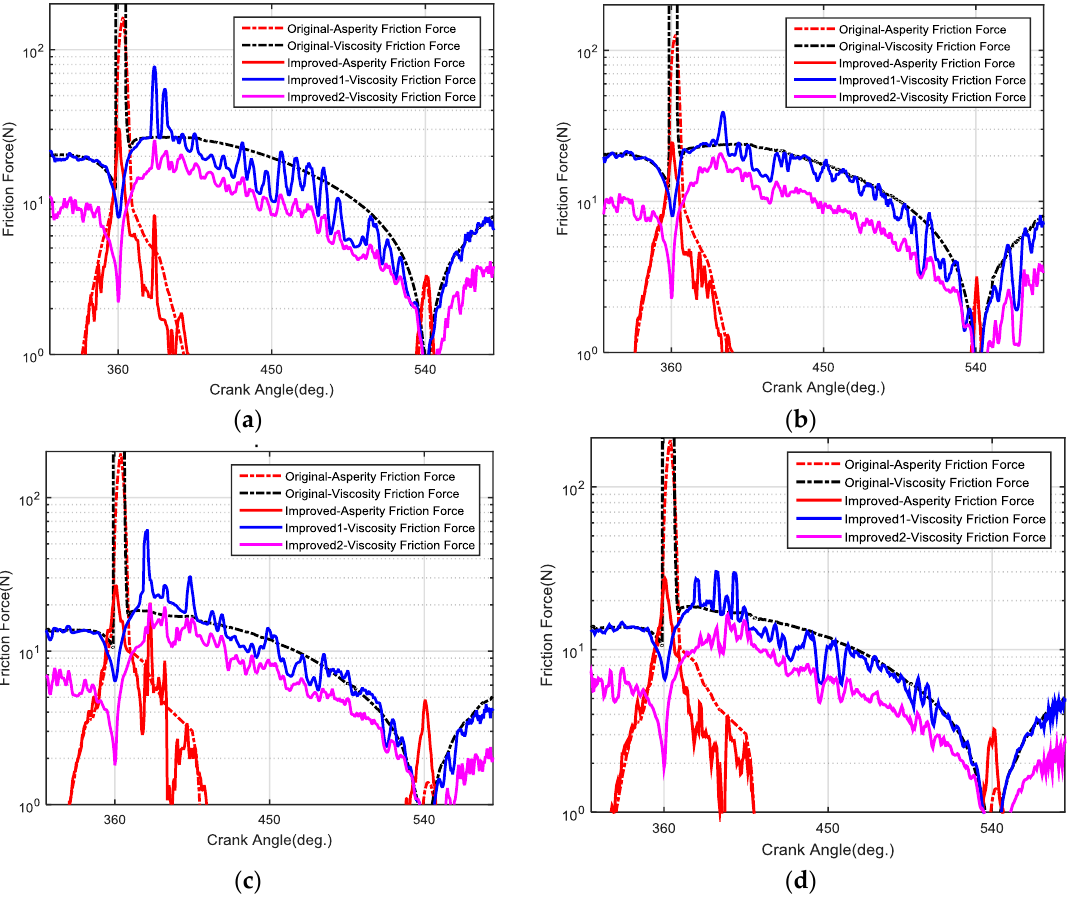
Figure 13. Enlarged view of friction forces predicted by three different models under four operating conditions: ( a ) 1800 rpm and 40 Nm; ( b ) 1800 rpm and 10 Nm; ( c ) 1000 rpm and 40 Nm; ( d )1000 rpm and 10 Nm.